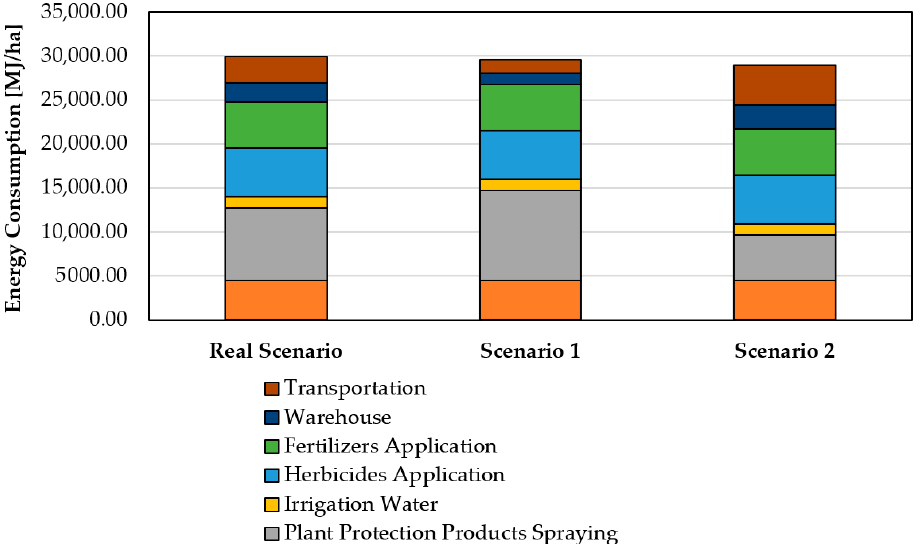
Figure 2. Specific energy consumption (MJ/ha), considering the operations of pruning, plant pro- tection products spraying, herbicides application, warehouse, soil maintenance (sown cover crop), irrigation water, fertilizers application and transportation for the real and test scenarios.